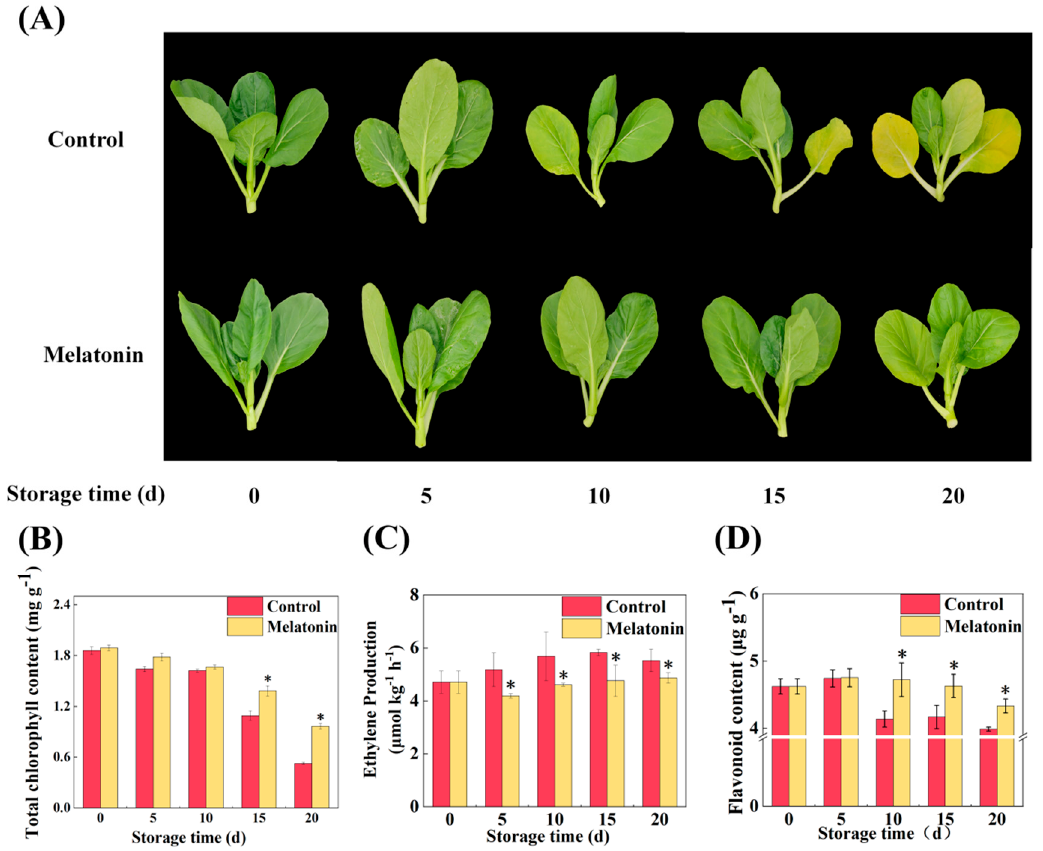
Figure 1. The effects of exogenous melatonin on the phenotype, chlorophyll content, ethylene production and flavonoid content of flowering Chinese cabbage at 4 ◦ C during 20 days storage. ( A ) The phenotype, ( B ) total chlorophyll content, ( C ) ethylene production, (D) flavonoid content. Control: 0 μ mol L − 1 melatonin (pure water). Melatonin: 100 μ mol L − 1 melatonin treatment. The vertical bars indicate the standard error of the mean (n = 3). The asterisks above columns indicate a significant difference at * p < 0.05.